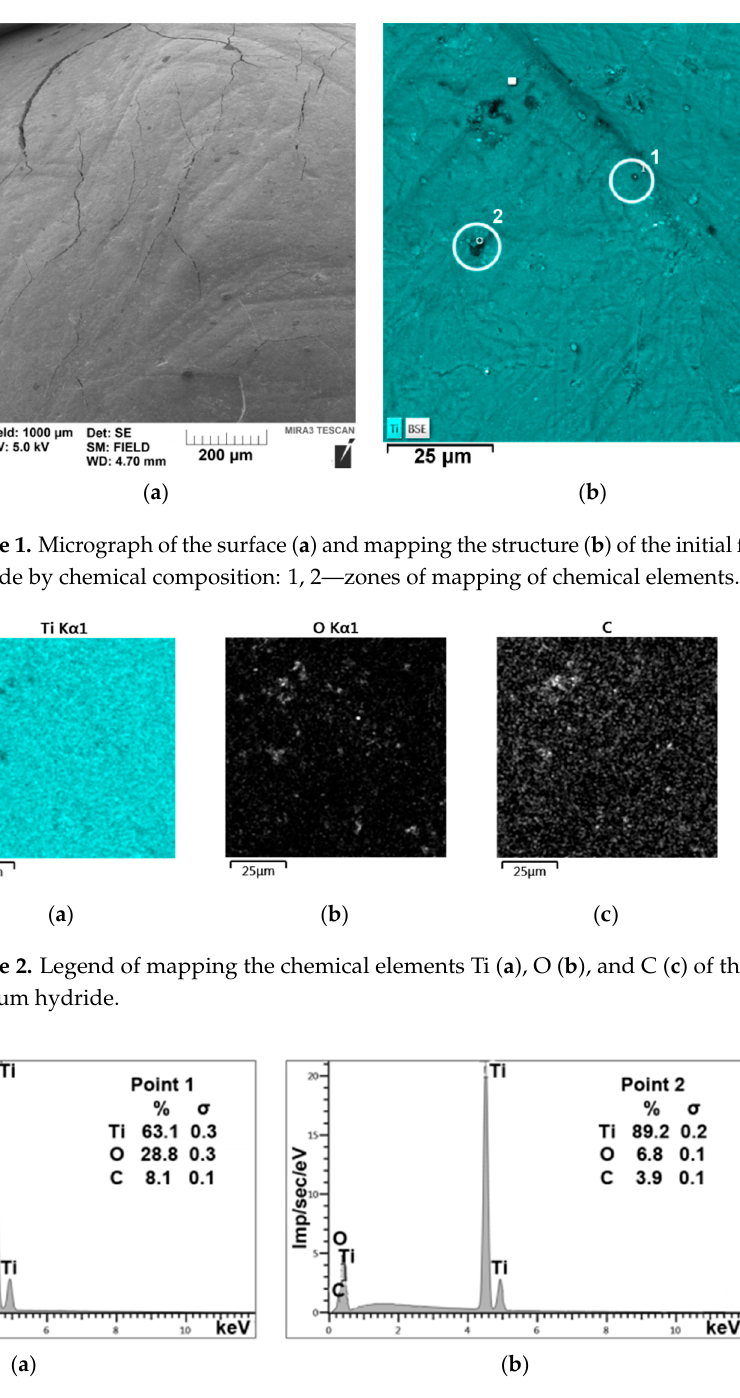
Figure 3. Energy dispersive spectra at different points of the initial fraction of titanium hydride (( a )—point 1, ( b )—point 2).